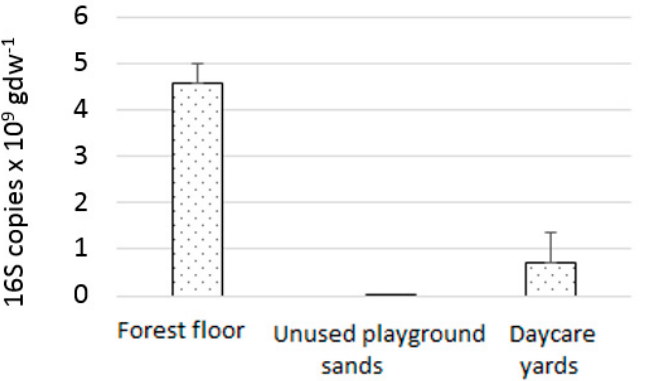
Figure 2. Bacterial numbers in the forest floor, unused playground sands, and samples from daycare yards taken before transforming the yards. 16S copies = copies of bacterial 16 S rRNA sequences per 0.250 g sample; gdw = gram dry weight.